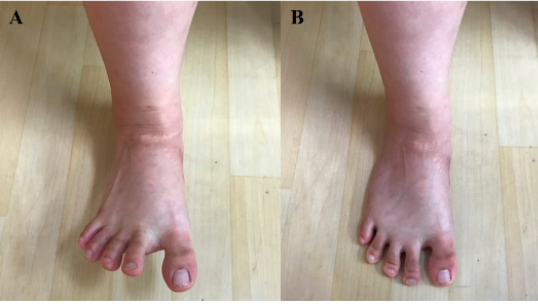
Figure 4. Toe spread out exercise: ( A ) start, ( B ) end.